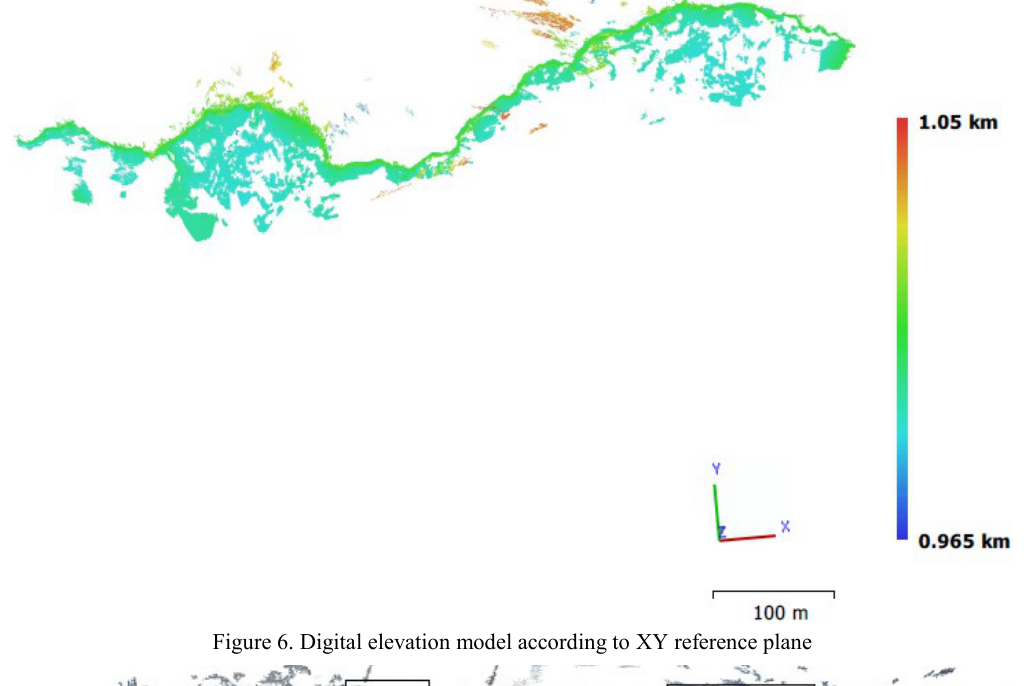
Figure 6. Digital elevation model according to XY reference plane